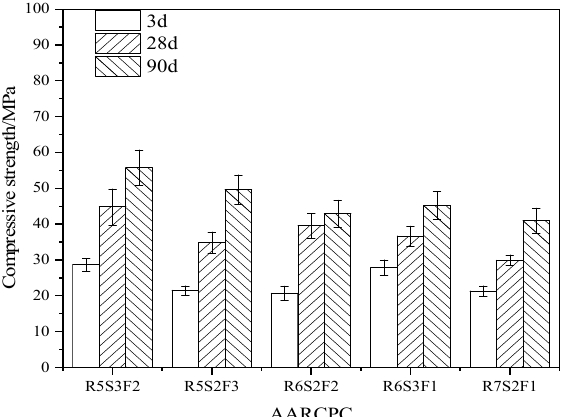
Figure 9. Compressive strength of AARCPC with composites composed of different fly ash and slag content.